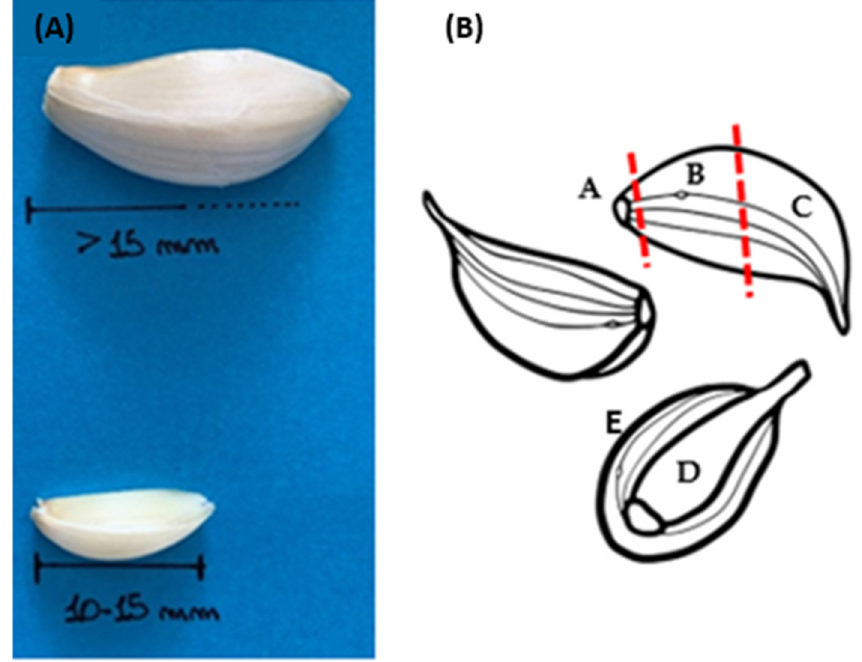
Figure 1. ( A ) Clove quality categories: first category cloves length >15 mm; second category clove lenght 10–15 mm; ( B ) garlic cloves sections considered in the different in vitro trials: A, base; B, central portion; C, upper portion; D, germ; E, outer tunics.